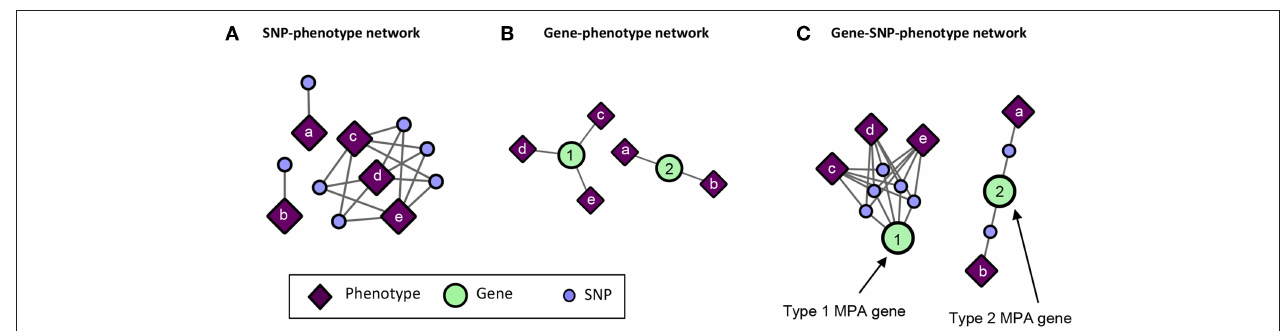
FIGURE 5 | Example of SNP-phenotype, gene-phenotype networks and gene-SNP-phenotype networks. (A) SNP-phenotype bipartite networks simply connect SNPs to phenotypes with which they have a significant association, and do not provide information regarding MPA signatures within genes. (B) Gene-phenotype networks contain connections between genes and phenotypes. An edge will be drawn between a gene and a phenotype if that gene contains a SNP associated with that phenotype. Gene-phenotype networks do not provide information as to which type of MPA signature is exhibited. (C) Gene-SNP-phenotype networks are SNP-phenotype networks with the SNPs connected to genes in which they reside. These networks are more complicated, and MPA signatures can be deduced from their structure through further analysis, however, the network is not in a form in which MPA signatures can be extracted easily using standard network topology measures such as